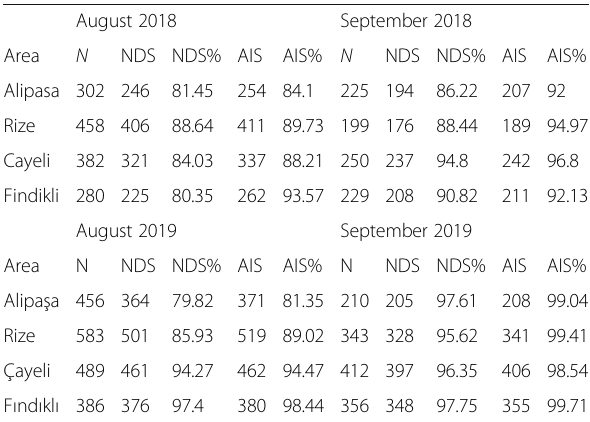
Table 1 Mortality rate and number of specimens infected with Beauveria bassiana over 2018 and 2019